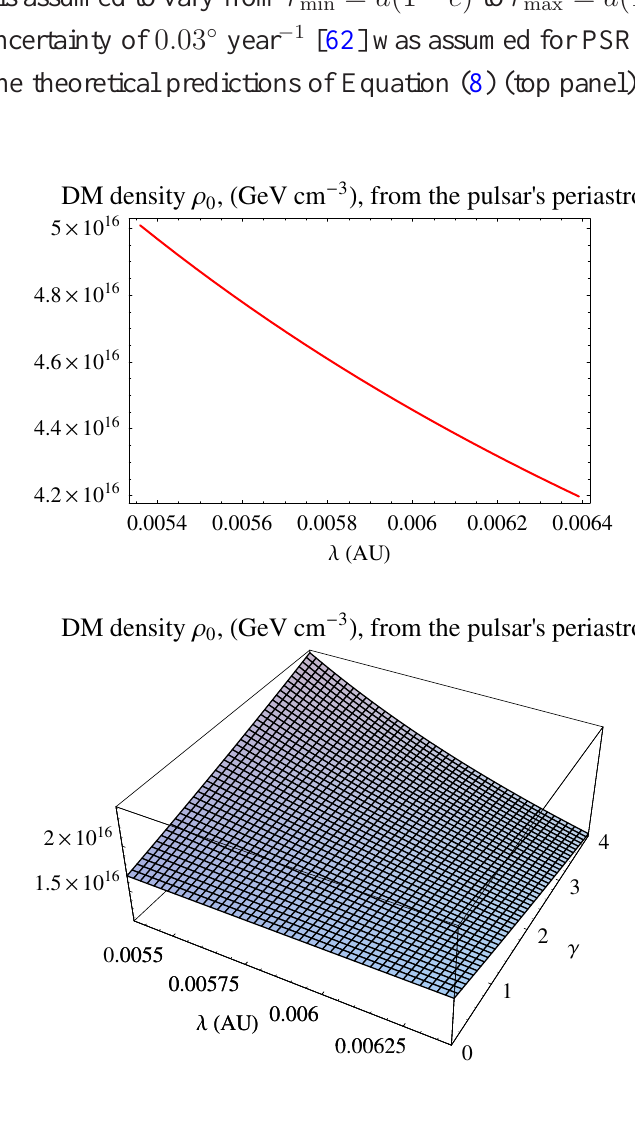
10 − 24 g cm − 3 ), × e ) to r max = a (1 + e ) . A conservative −